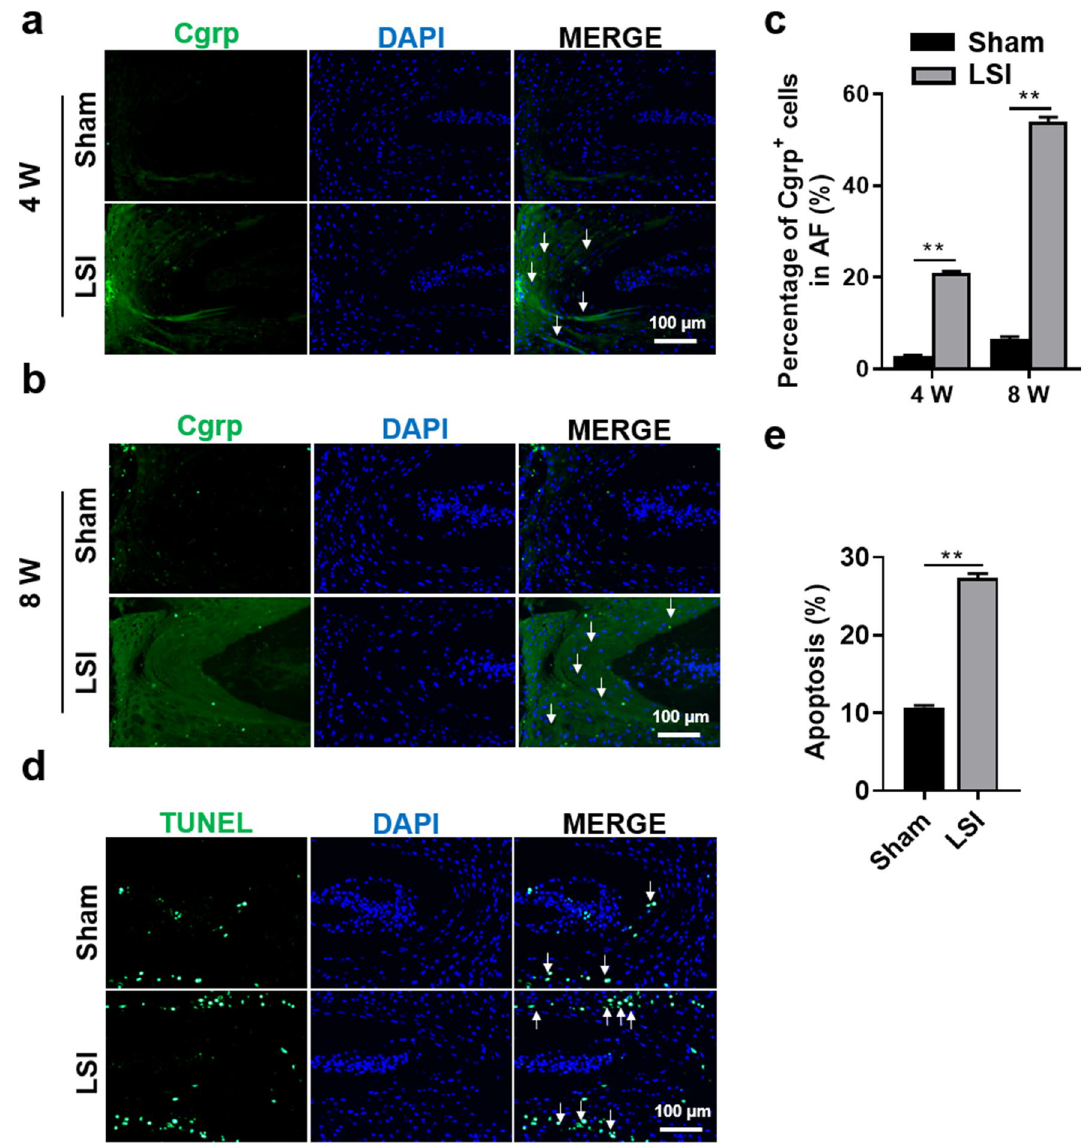
Figure 4. Aberrant mechanical stress stimulated sensory nerve invasion into IVD tissues and deteriorates apoptosis of IVD cells. ( a , b ) Immunofluorescence staining for Cgrp expression (green) at 4- and 8-W post- surgery. DAPI stains nuclei blue. White arrows indicate high expression of Cgrp in AF. ( c ) Quantification of Cgrp-positive cells in AF region of ( a , b ). ( d ) Apoptosis images of the IVD sections. DAPI stains nuclei blue. White arrows indicate apoptosis in EP cells. ( e ) Quantification of apoptosis rate in ( d ). Data are shown as mean ± sem. Three independent experiments were performed in triplicate. * P < 0.05, ** P < 0.01 compared to Sham